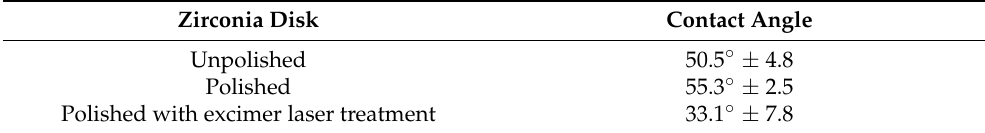
Figure 2. Arithmetic surface roughness (Sa) of zirconia disks. The Sa value was significantly lower in polished disks and in polished disks irradiated with an excimer laser compared to unpolished disks. ( n = 5). Table 2. Contact angle values of zirconia disks. Data represent means (± SD).